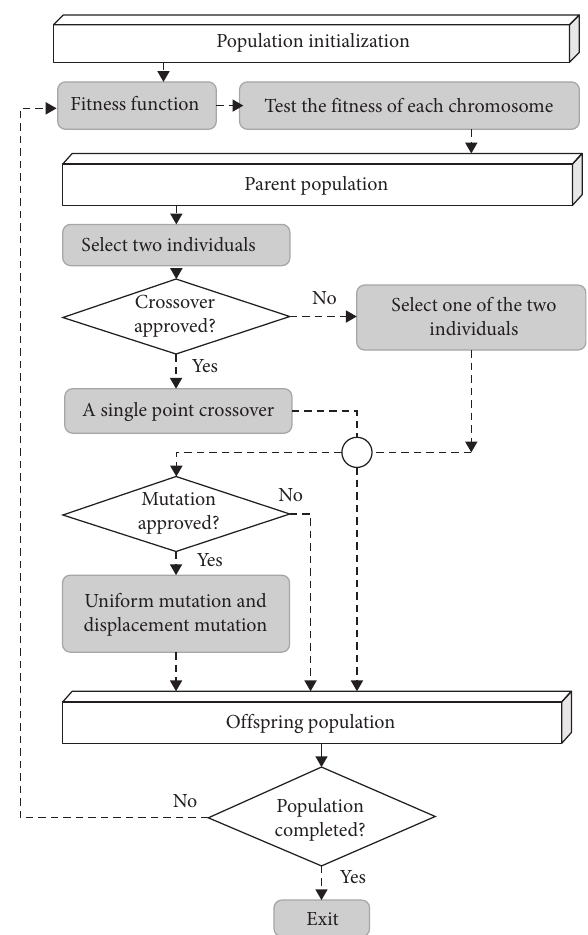
Figure 2: Flowchart of the proposed GA-based algorithm to model (III).